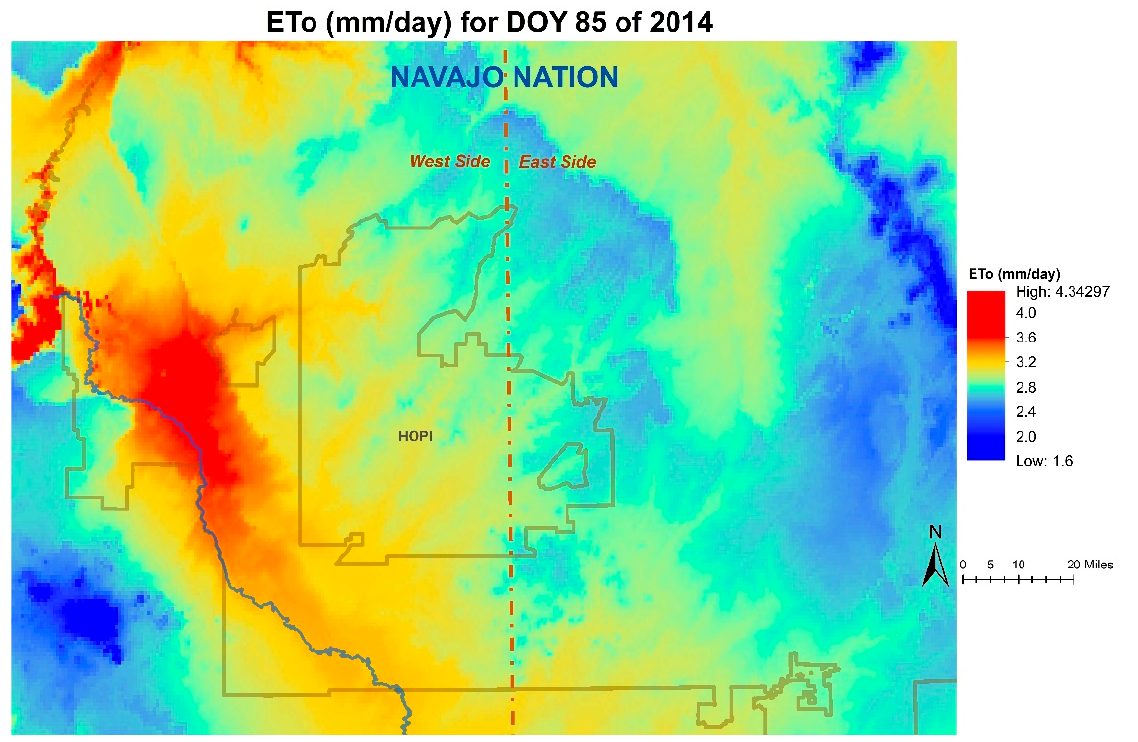
Figure 6 . Map of potential evapotranspiration (ETo, mm/day) using Daymet (1 km resolution) for a single date (DOY 85) in 2014 for the northeast corner of Arizona which includes both the Hopi and Navajo Reservations and parts of the Little Colorado River watershed.